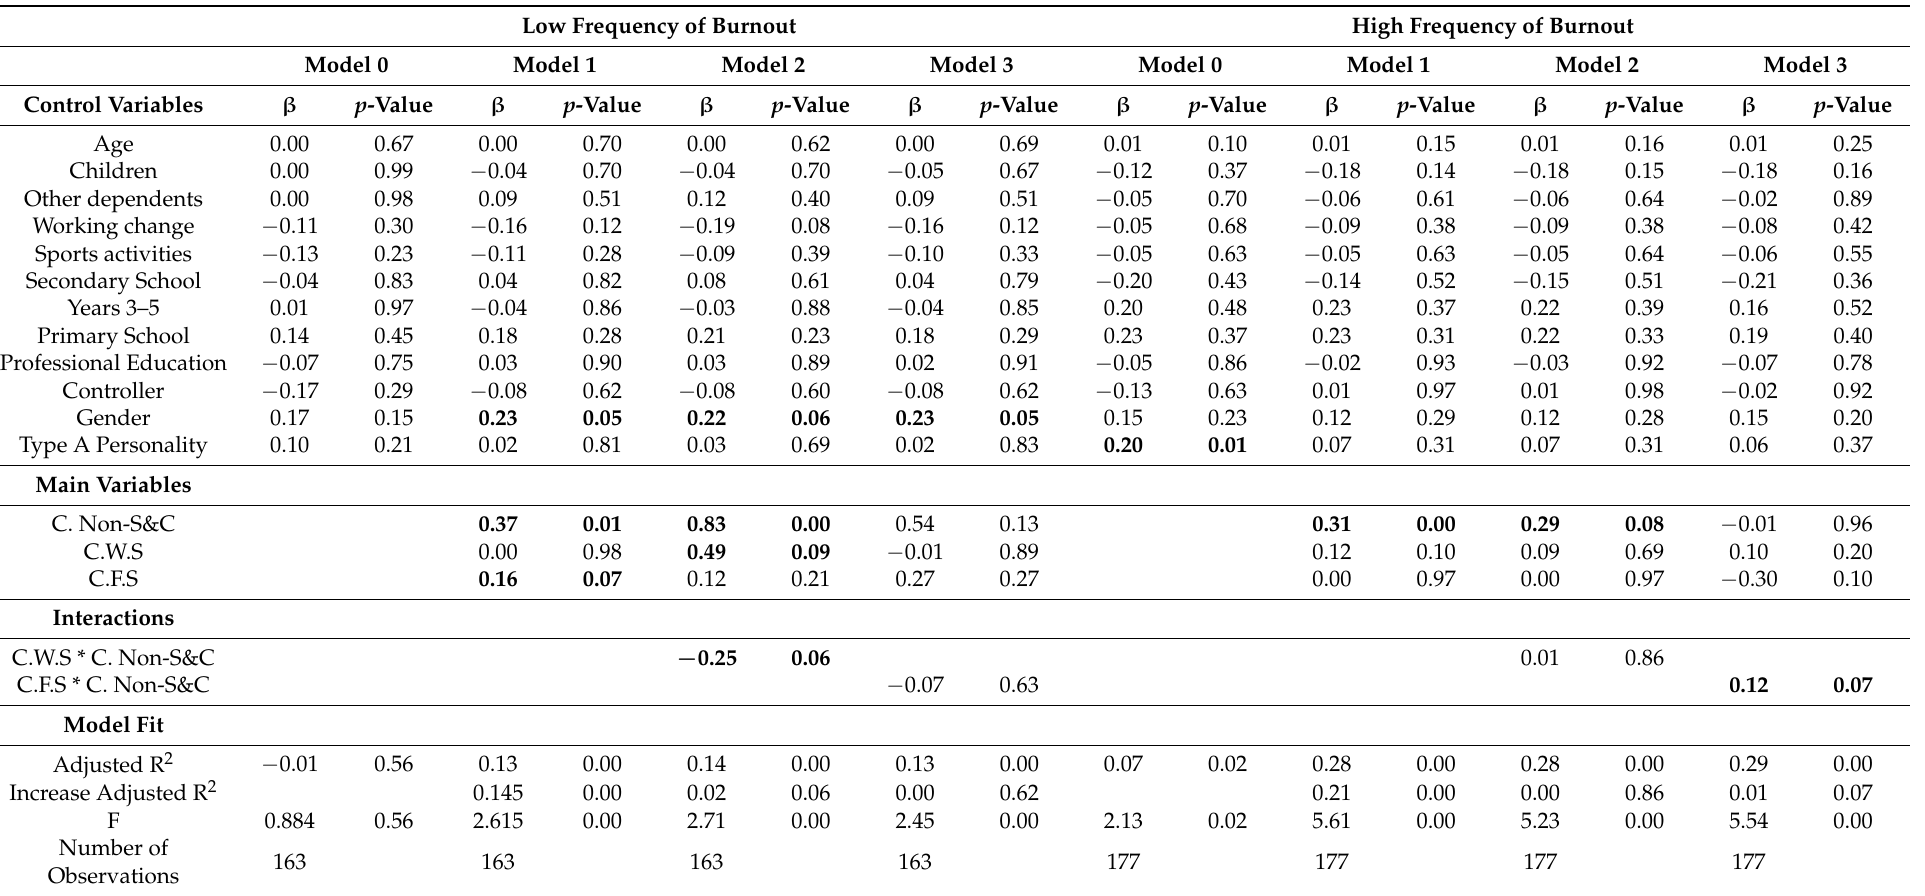
Table 2. Regression models for the frequency of stress in low burnout and high burnout